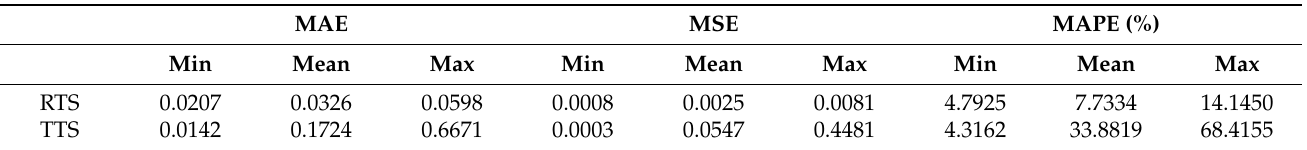
Table 2. Goodness of fit indicators of RTS and TTS.